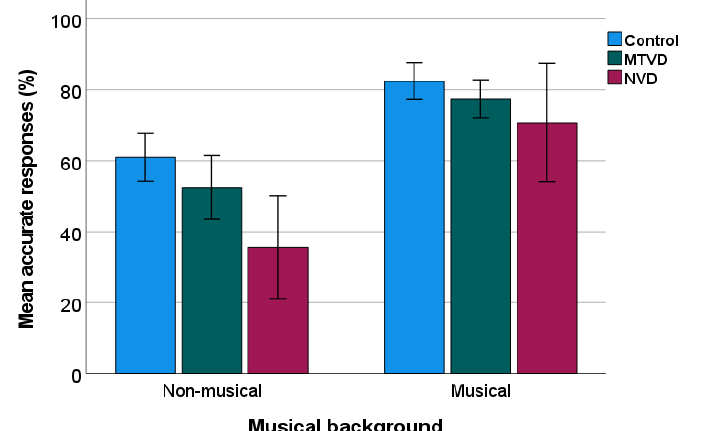
Figure 2. Percentage of PD accuracy in sub-groups. Error bars indicate standard errors. MTVD: muscle tension voice disorder; NVD: neurological voice disorder.